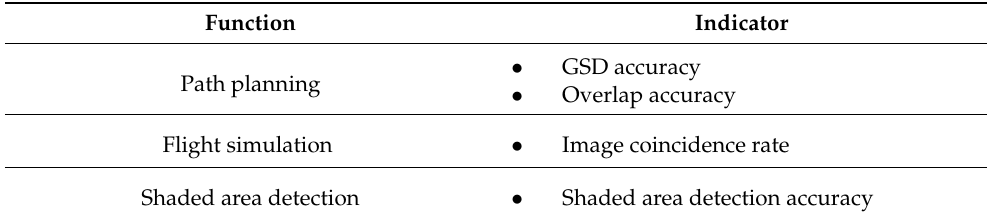
Table 2. Functions and indicators for validation of the simulator.